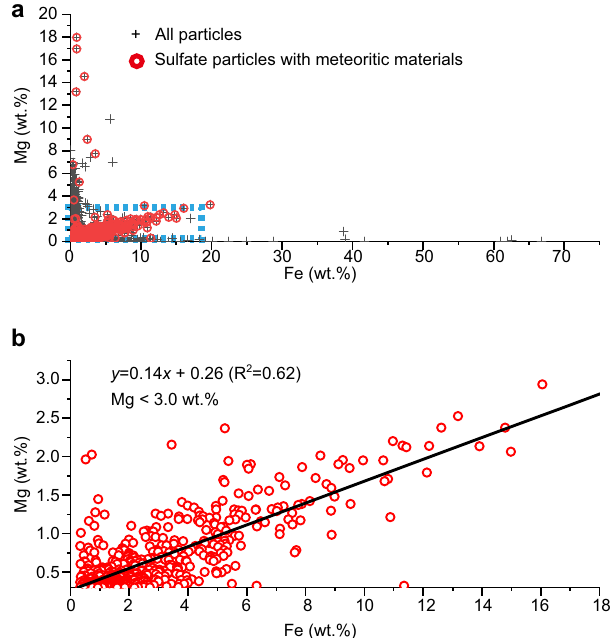
Fig. 3 Relationship between Fe and Mg within sulfate particles with meteoritic materials measured using STEM-EDS. The plots contain 23,376 data points representing all particles and sulfate particles with meteoritic materials are represented by a 571 (all Mg values) and b 560 (Mg < 3 wt%) data points. Top: all particles. Bottom: only sulfate particles with meteoritic materials and Mg < 3 wt% are shown. The linear fi tting was calculated using a York regression 55 .